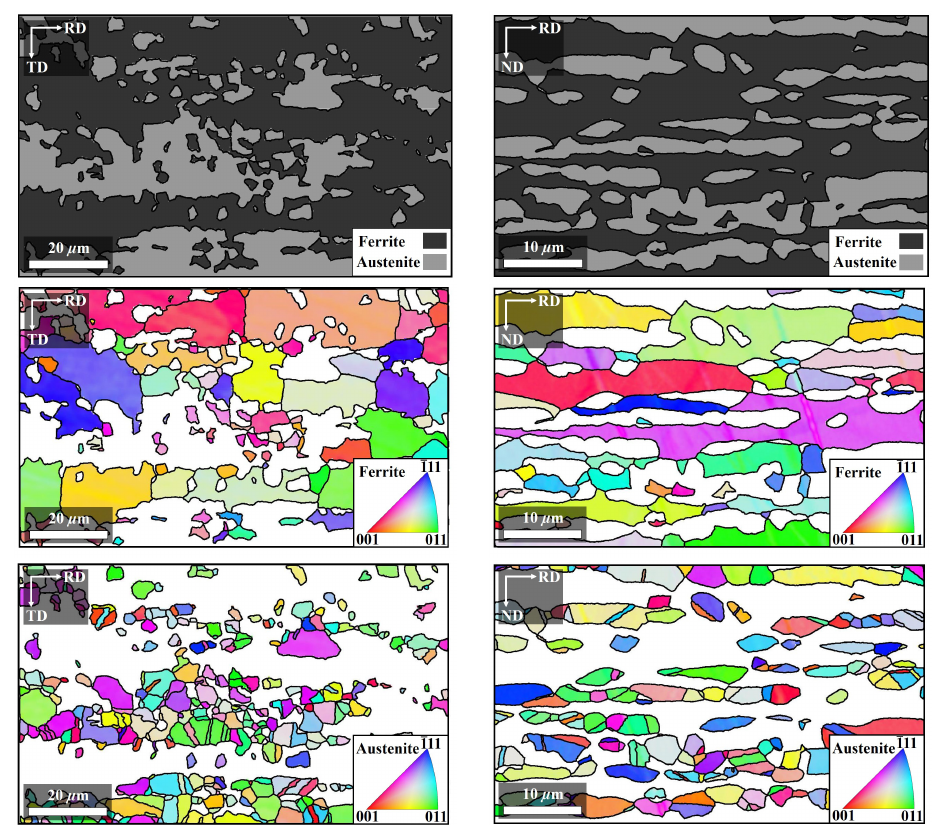
Figure 1. Electron backscatter diffraction (EBSD) phase index maps ( top ) and orientation maps of ferrite ( centre ) and austenite ( bottom ) for plane section ( left ) and cross section ( right